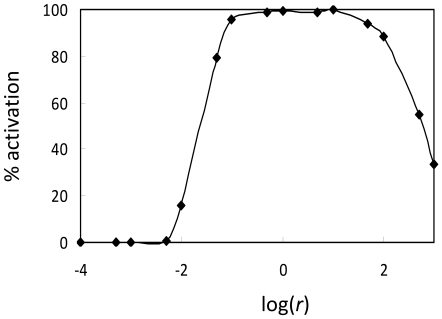
Percentage of randomly selected immune parameter sets that activate as a function of pathogen growth rate, r.For this figure we use αr ∈ [1, 100], 0.99αr<α
17<αr, 0.1αr<βr<0.5αr, 0.99βr<β
17<βr, βr/Kr<μr<1.05βr/Kr, μr<μ
17<1.01μr, Kr ∈[1], [10], Kr<K
17<1.01Kr, γ ∈[1], [10], 30αr (β17/K17−μ17+βr/Kr−μr)/Kr<τ<100αr (β17/K17−μ17+βr/Kr−μr)/Kr, δ = 1×10−10, v = 1×10−14, and p = 3. Parameter ranges and justifications for parameter relationships are discussed further in Supporting Information S1.